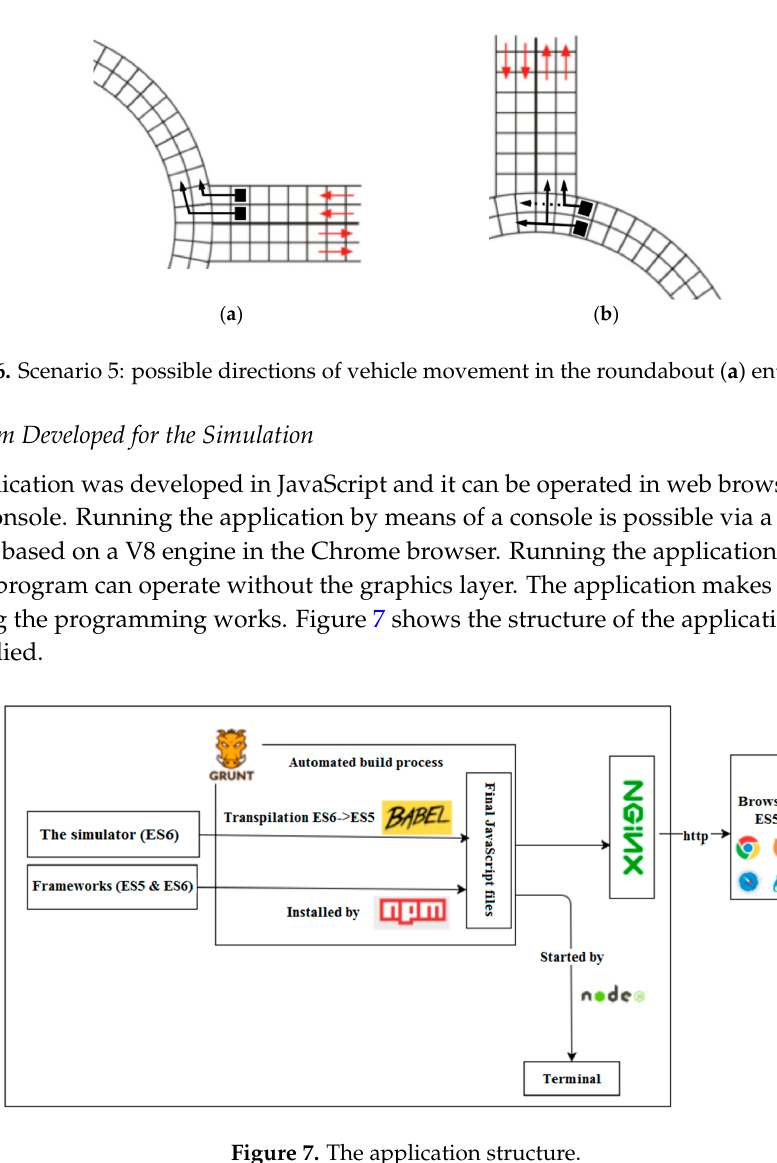
Figure 7. The application structure.